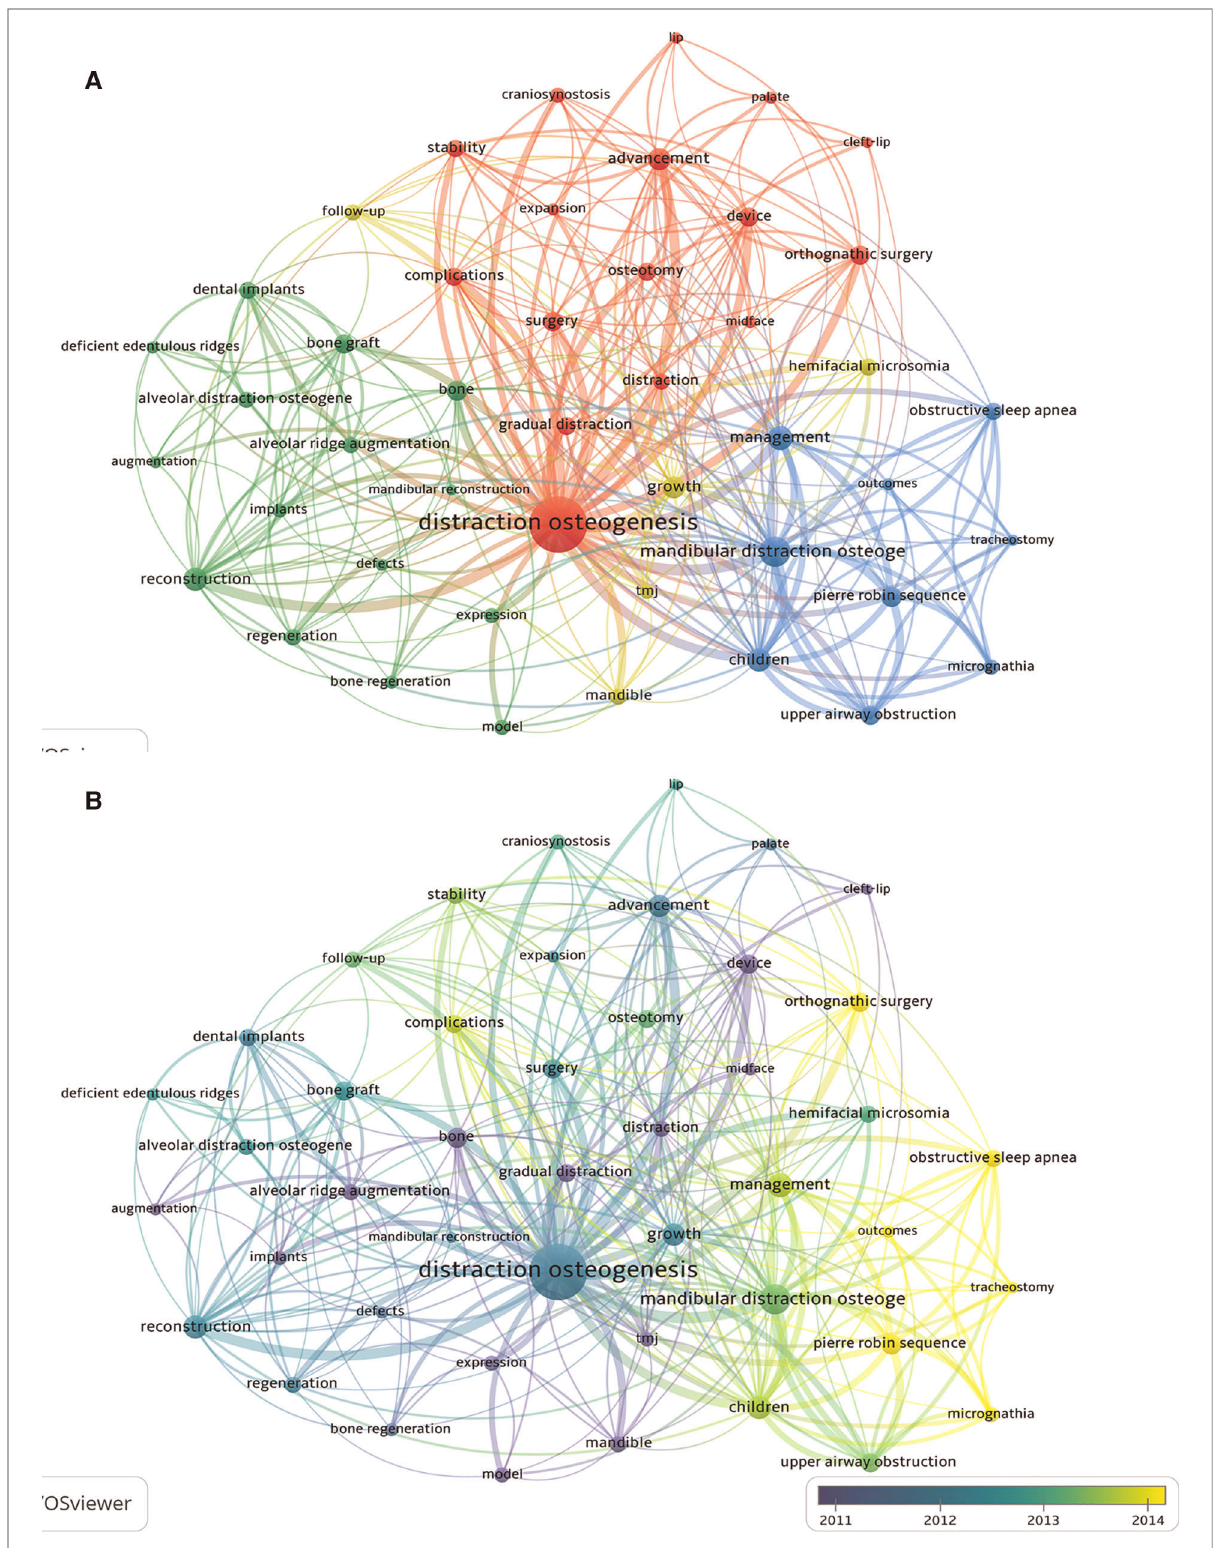
FIGURE 6 The co-occurrence network of keywords related to research on craniomaxillofacial distraction osteogenesis from 2000 to 2021. ( A ) Clustering analysis of keywords; ( B ) Timeline view of keywords with frequency no less than